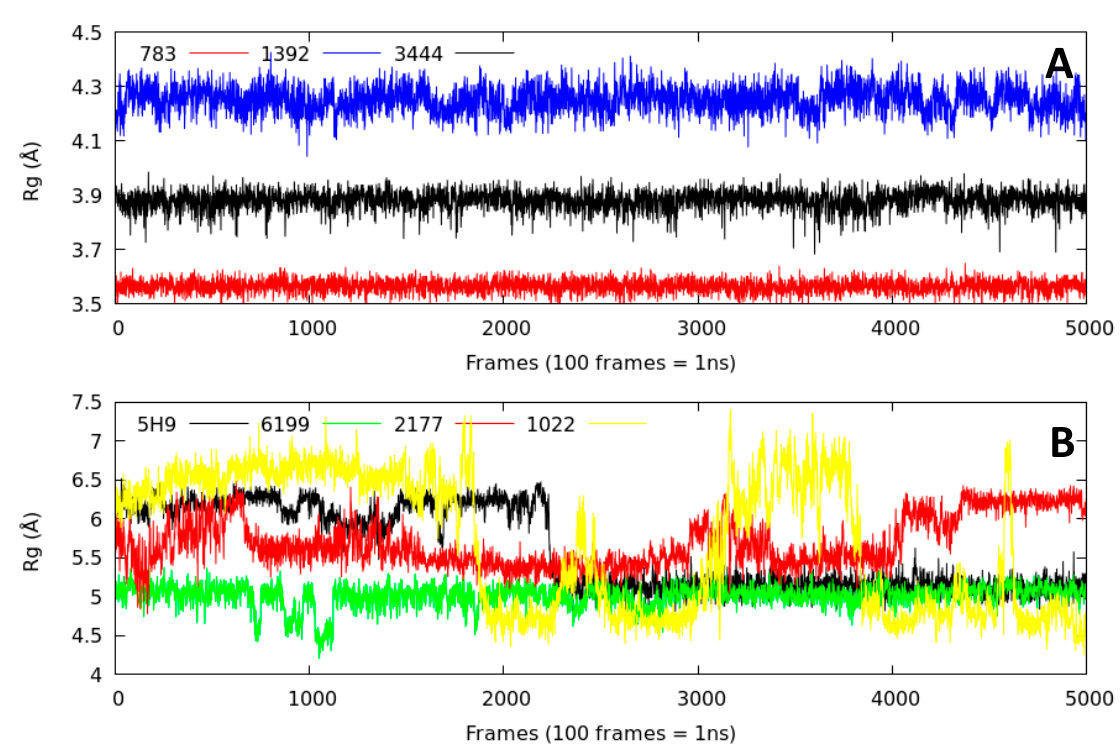
Figure 6. The radius of gyration (Rg) of C α atoms in the ligand–5DPF complexes during 50 ns of molecular dynamics simulation. ( A ) is the comparison between Lig783, Lig1392 and Lig3444. ( B ) is the comparison between Lig5H9, our reference compound, Lig6199, Lig2177 and Lig1022.